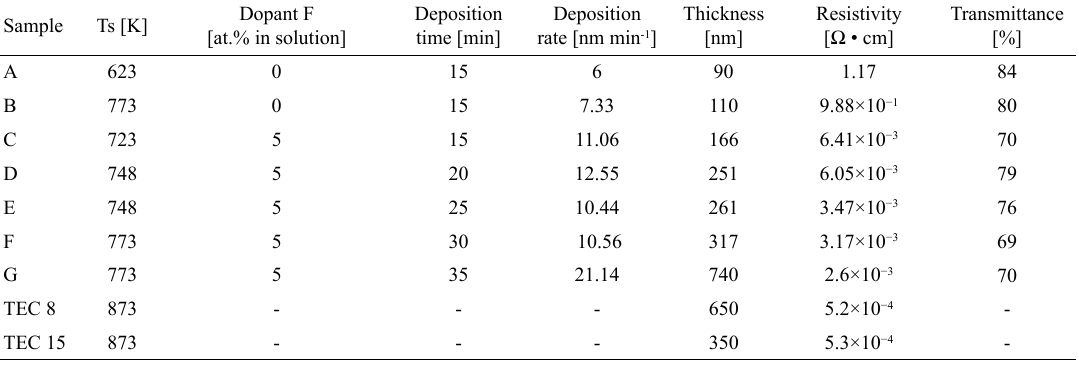
Table 1: Temperature and time deposition, concentration of dopant fluorine in precursor solution, thickness of the samples, and also is presented commercial materials (TEC 8 and TEC 15) (produced by Pilkington NSG) 12,26 . Also is presented the resistivity value and percentage of transmittance obtained for each sample.